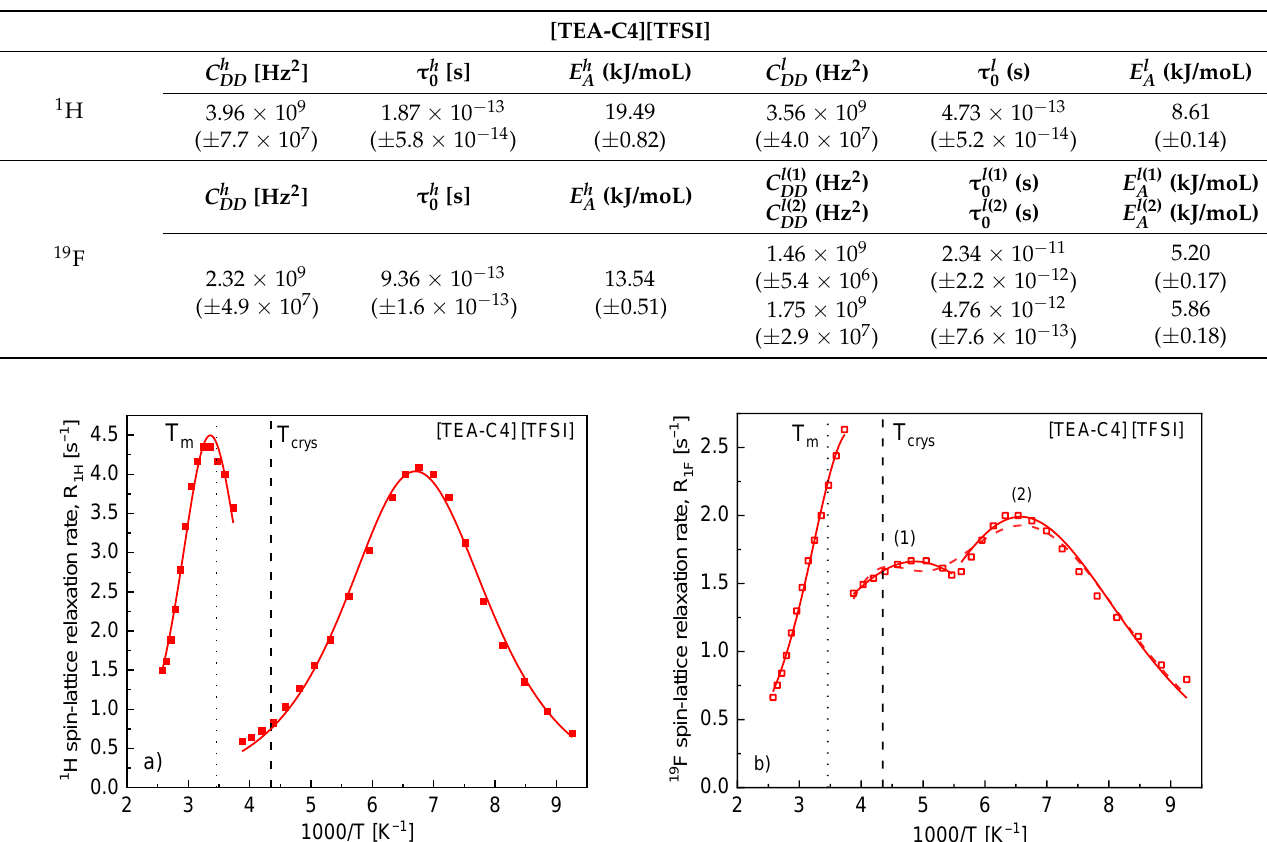
Table 1. Parameters obtained from the analysis of the 1 H and 19 F spin-lattice relaxation data for [TEA-C4][TFSI].